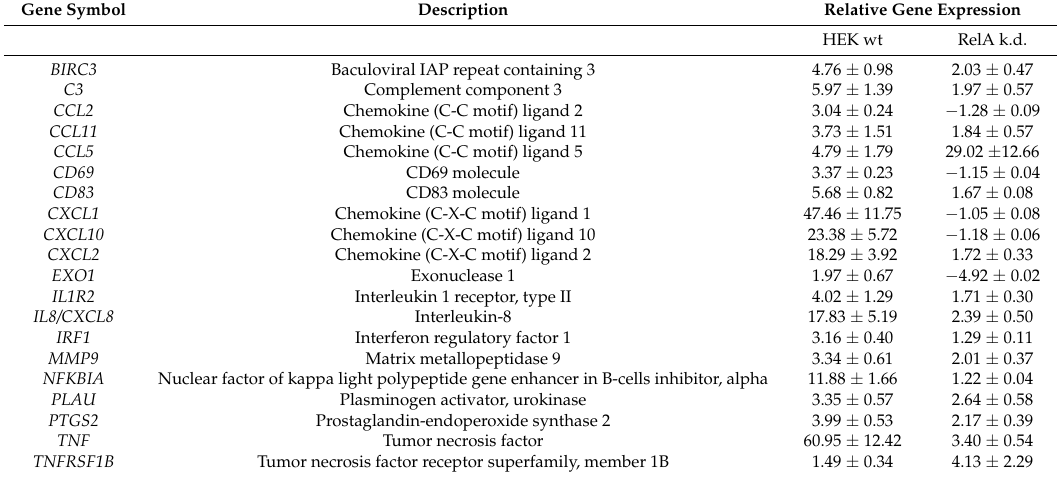
Table 2. TNF- α * induced gene expression in HEK shRNA RelA cells (RelA k.d.) compared to